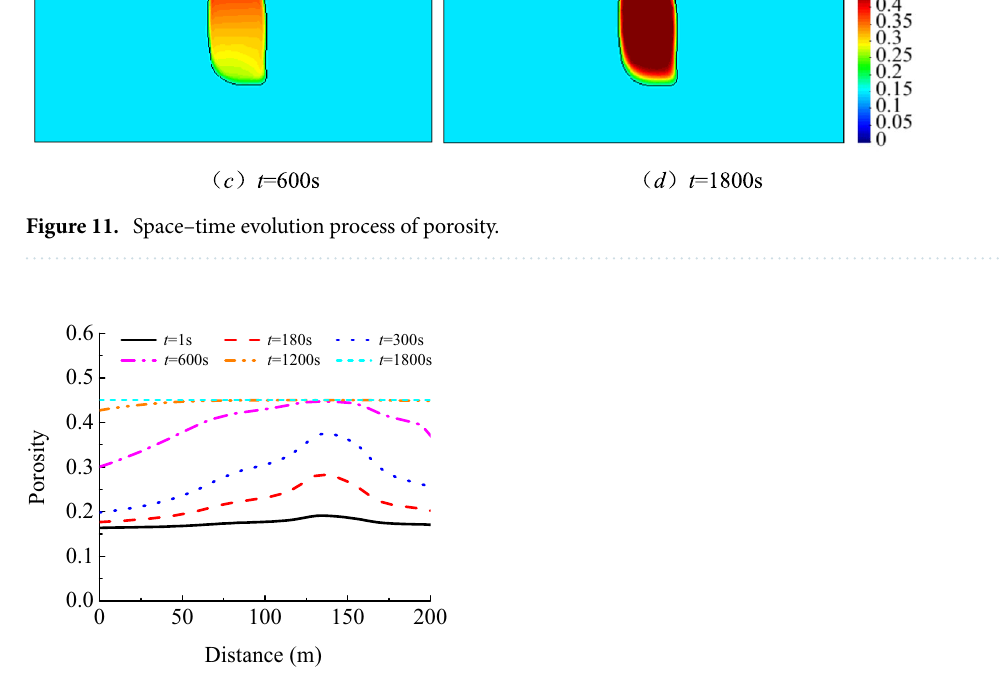
Figure 12. Porosity distribution of measuring line A 2 A 4